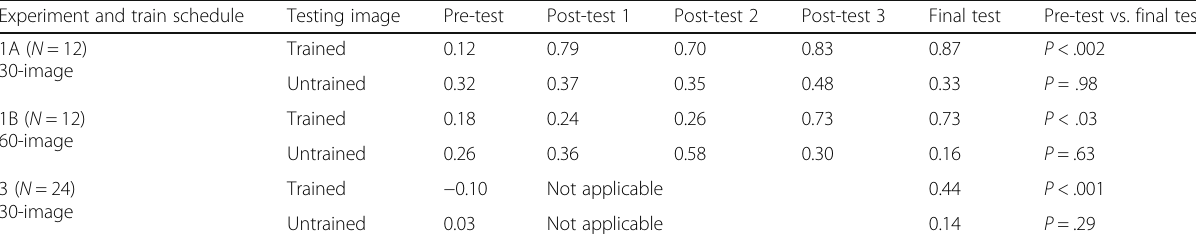
Table 4 Mean d ’ for classifying images with the tumor region removed ( “ background ” ) Experiment and train